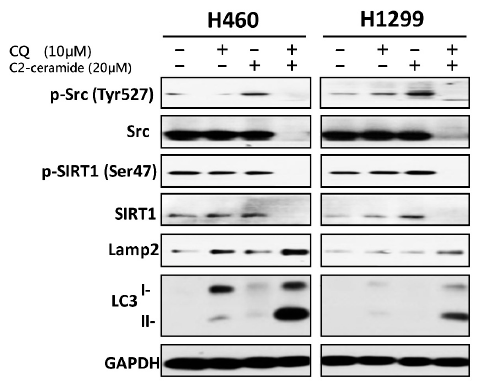
Figure 6. Cell survival and autophagy-related proteins were regulated by combined treatment with C 2 -ceramide and CQ. Western blot analysis of p-Src, Src (tyrosine kinase), p-SIRT1, SIRT1 (autophagy initiator), LAMP2 (lysosome fusion), and LC3 (autophagosome maturation) in H460 and H1299 cells after 24-h treatment with C 2 -ceramide and